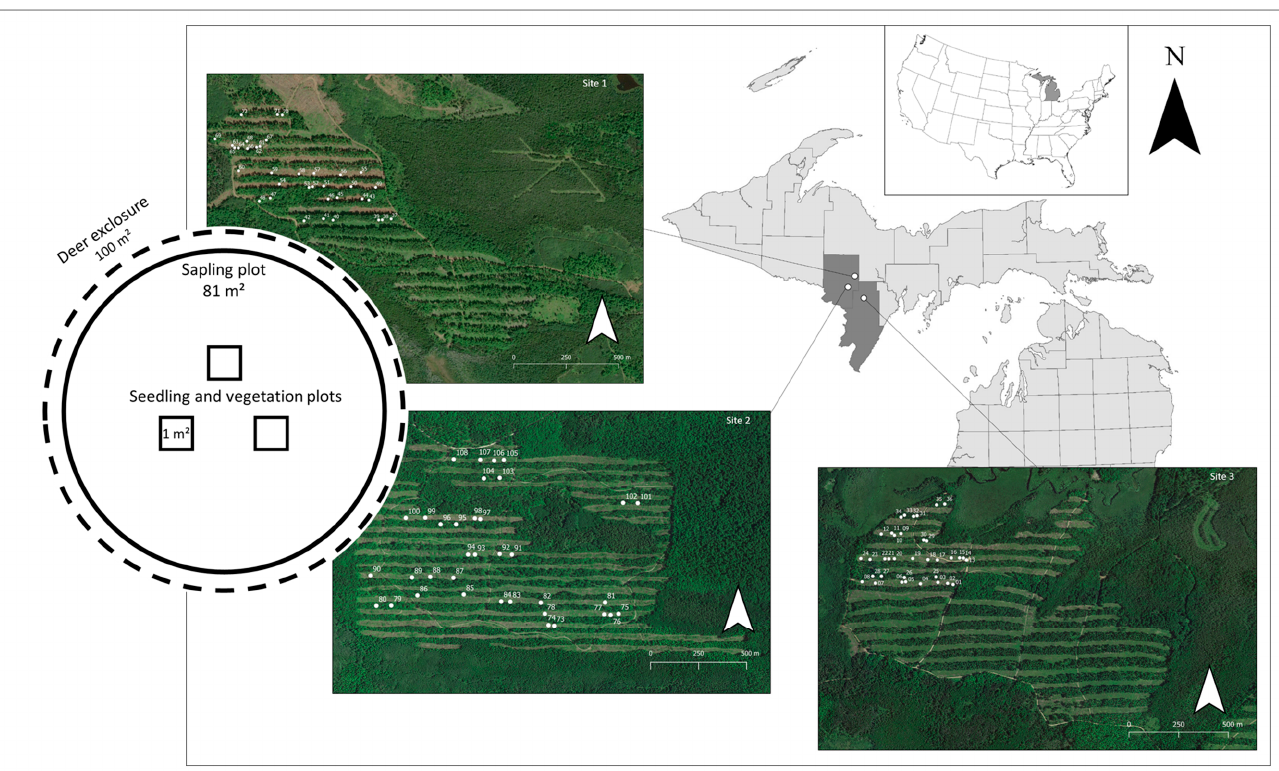
Figure 1. Experimental plot design and site locations in the Dickinson and Menominee counties in the Upper Peninsula of Michigan, USA. Numbers within each site denote plot numbers. Plot sizes are not to scale. Sites are managed by American Forest Management, Inc. (Charlotte, NC, USA). Satellite imagery retrieved from Google.